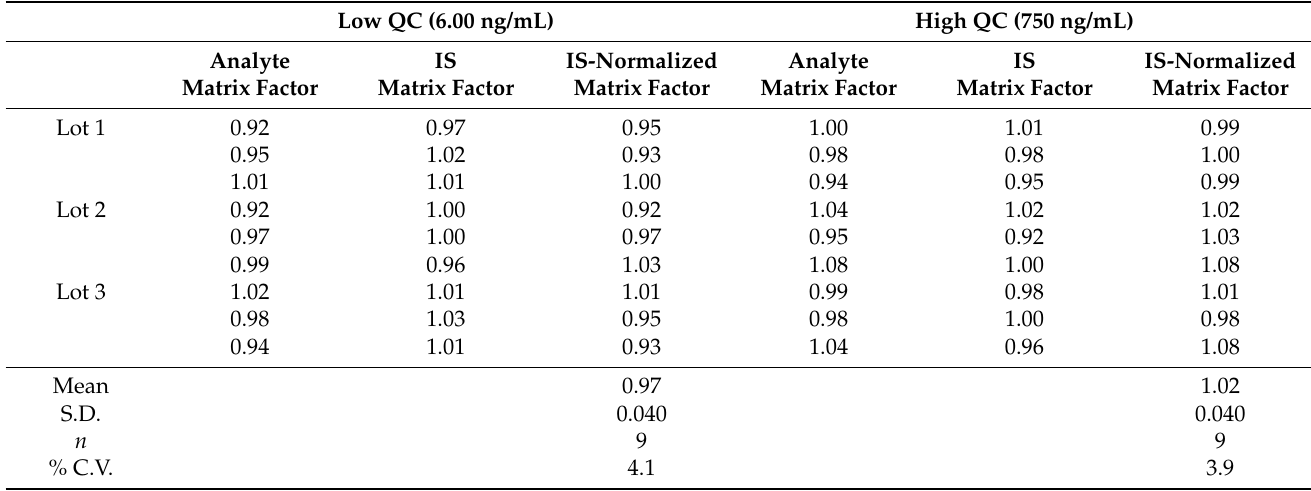
Table 4. Matrix effect of the analysis of siRNA-01 in monkey